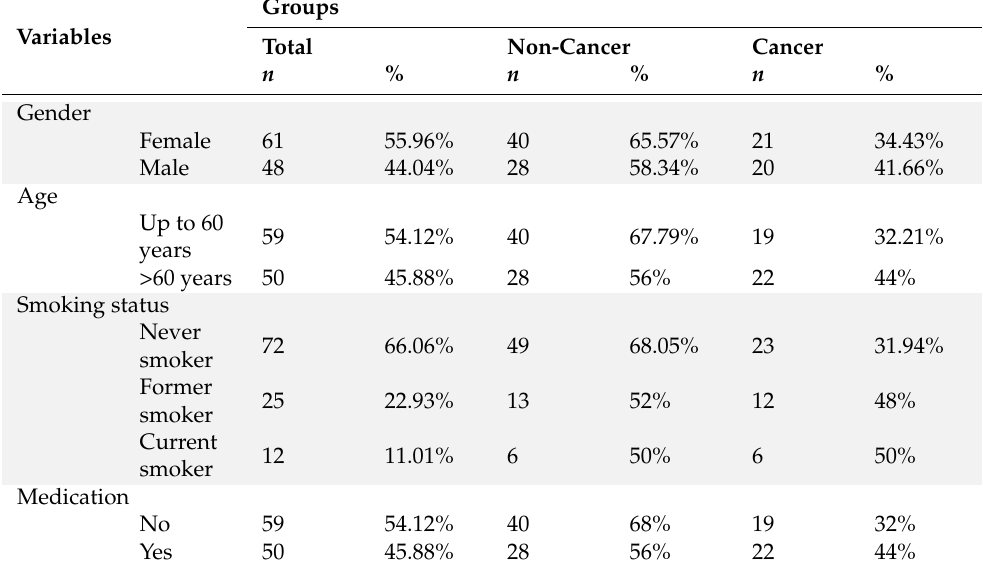
Table 1. Clinical–demographic